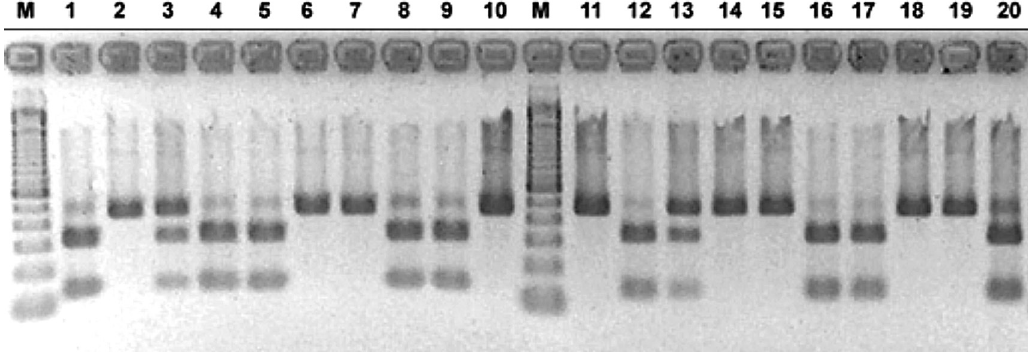
Figure 2. RT-PCR-RFLP pattern of leaf samples infected with different infection mixtures of Tomato spotted wilt vi- rus isolates, following amplification using primers 1F/1R and digestion with Xba I (lanes 1–10) or Ava II (lanes 11–20). M, 100 bp DNA ladder marker; lanes 1 and 10 digestion products of GRAU and ZO isolates respectively; lanes 2, 3, 4 and 5 digestion products of infectious mixtures 15 days after the first inoculation of GRAU vs. ZO, GA1L vs. ZO, GRAU vs. LL-N.05, and GA1L vs. LL-N.05, respectively; lane 6, digestion products of infectious mixtures 15 days after the third passage of GRAU vs. ZO; lane 7, digestion products of infectious mixtures 15 days after the fourth passage of GA1L vs. ZO; lanes 8 and 9, digestion products of infectious mixtures 15 days after the tenth passage of GRAU vs. LL-N.05 and GA1L vs. LL-N.05 respectively. Lanes 11–20, same order for Ava II as lanes 1–10 for Xba